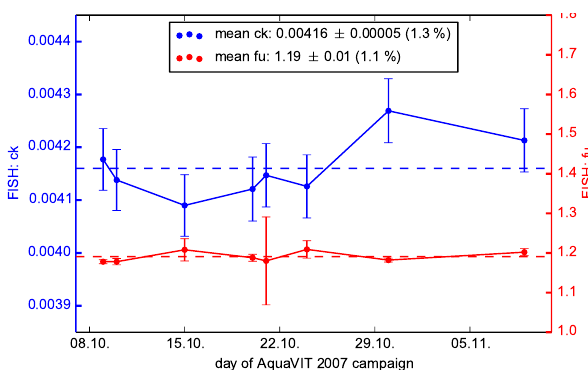
Figure 7. Time series for the calibration constants c k and f u during the AquaVIT-1 campaign evaluated with the enhanced calibration